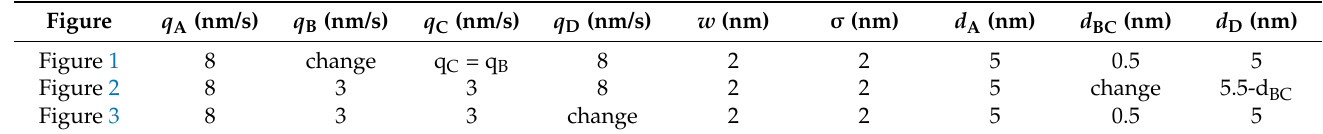
Table 1. The parameters used for the simulations of Figures